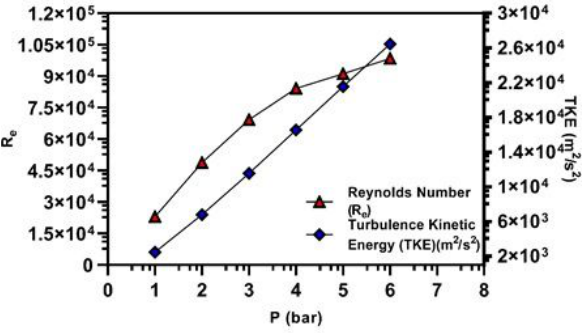
Figure 12: Graph between Reynolds Number and turbulence kinetic energy at varying inlet